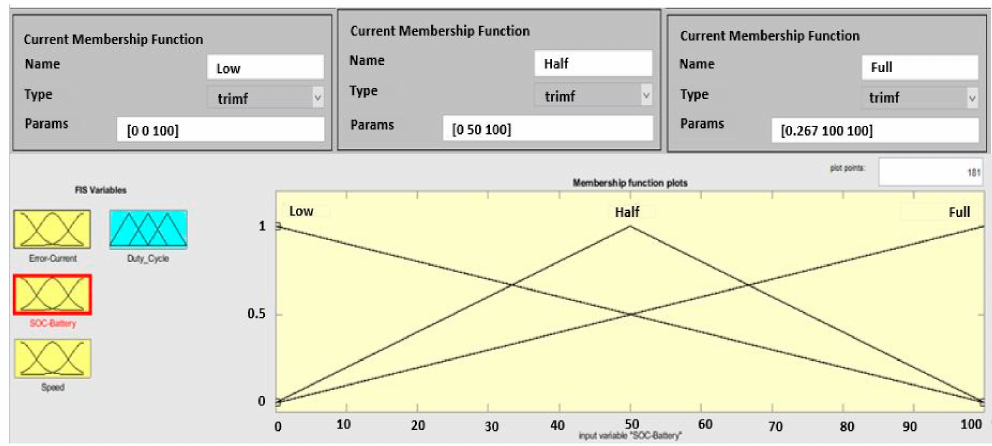
Figure 9. Membership functions of battery’s